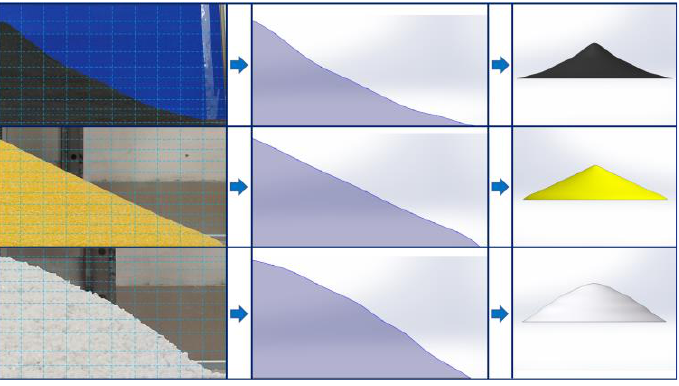
Figure 5. Schematic diagram of contour curve extraction method.